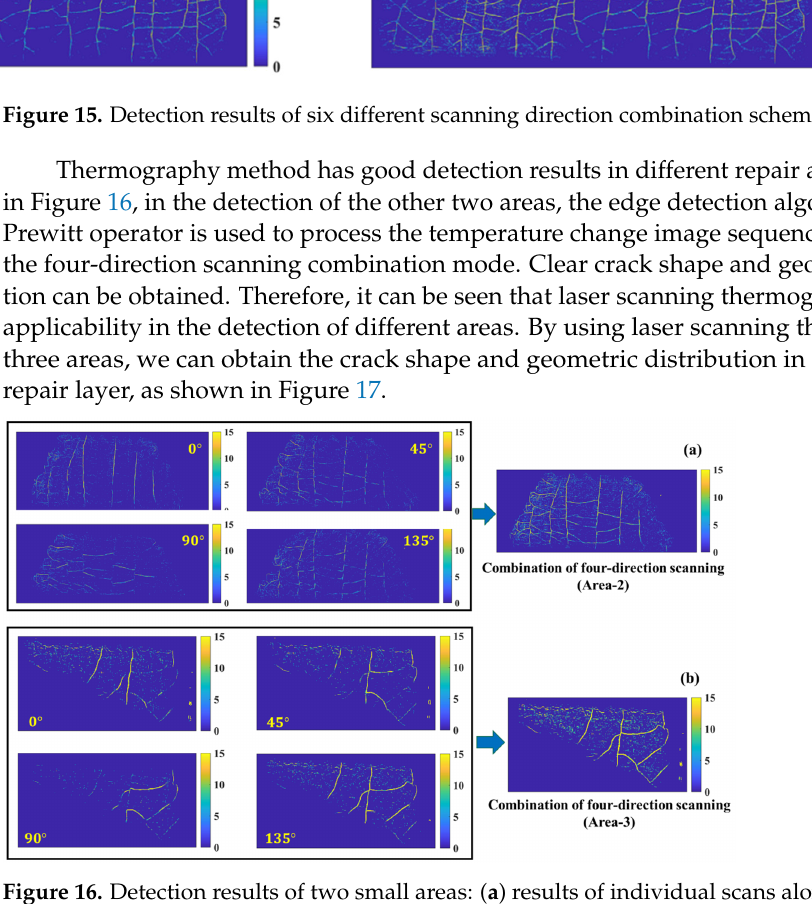
Figure 16. Detection results of two small areas: ( a ) results of individual scans along each direction and their superimposed results in Area ‐ 2; ( b ) results of individual scans along each direction and their superimposed results in Area ‐ 3.